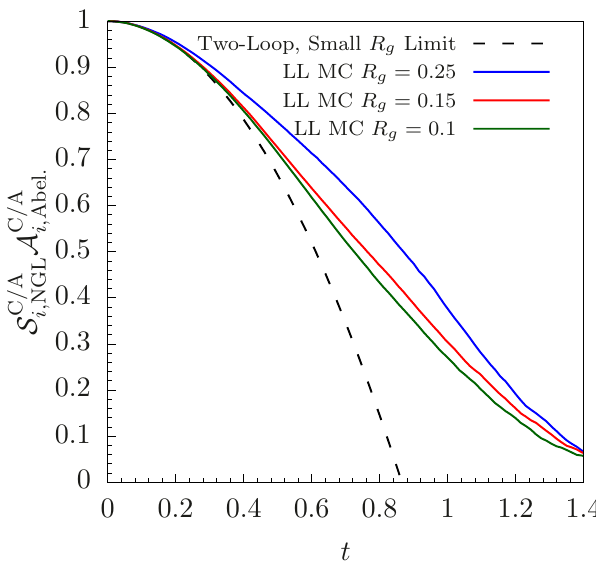
Figure 3 . The NGL+clustering distribution at large- N c at LL (overall accuracy NLL) for an initial fundamental (quark) dipole at various soft drop angles, compared to the small R g limit of the NNLO leading NGL of eq. (2.41) and large- N c limit of the clustering e(cid:11)ects in eq.